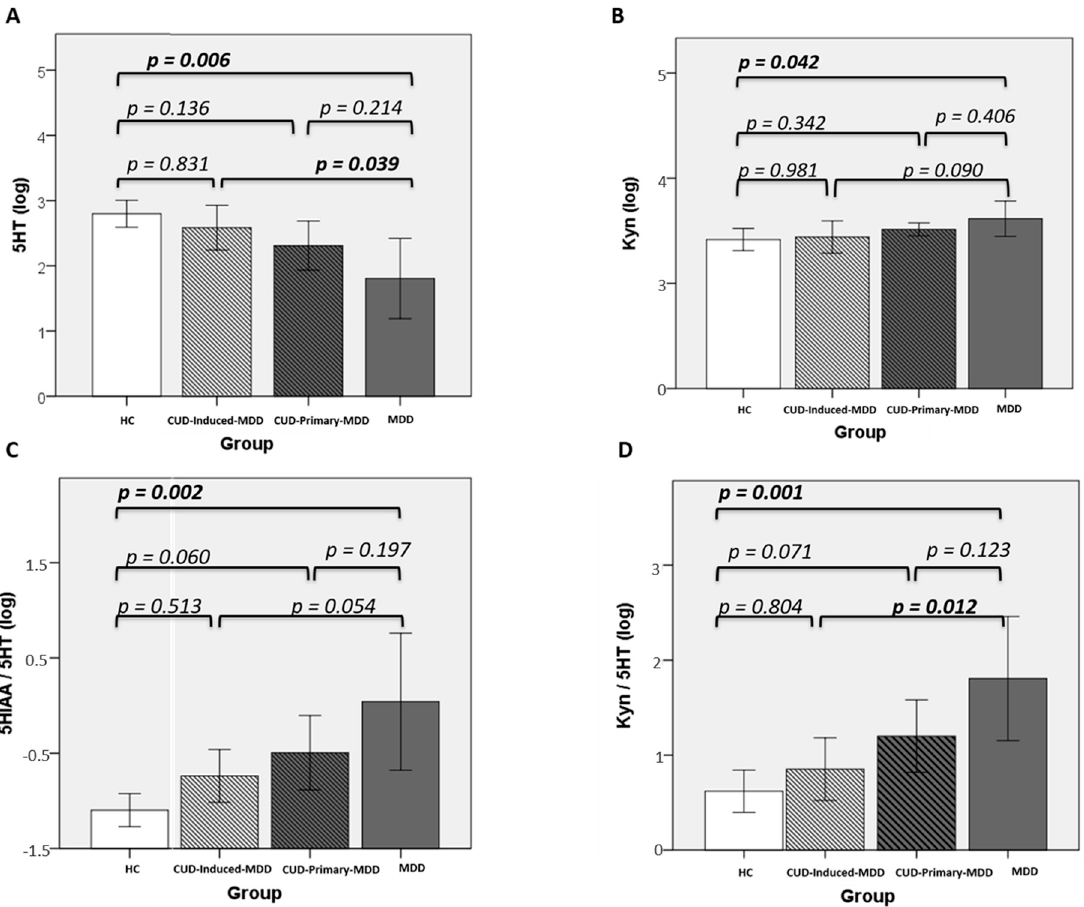
Figure 3. Variations observed in the four selected markers for the CUD-induced/primary depression groups compared with HC and MDD. ( A ) 5-HT, ( B ) Kyn, ( C ) 5HIAA/5-HT, and ( D ) Kyn/5-HT. Post-hoc comparisons were performed with Dunn’s Test.